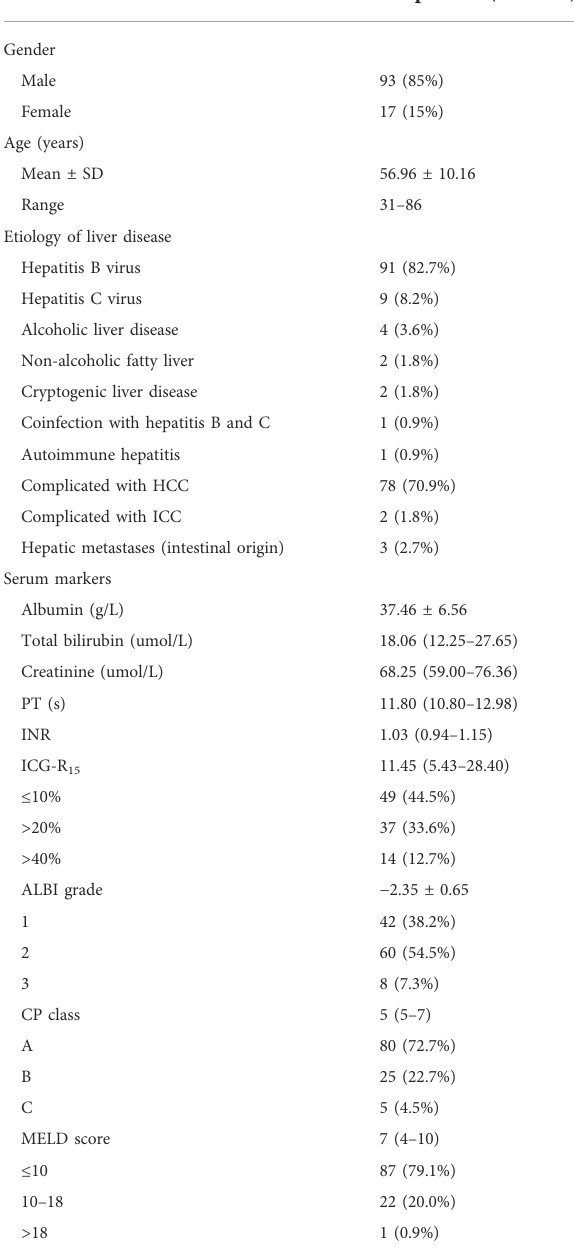
TABLE 3 Baseline characters of the study population. HCC, hepatocellular carcinoma; ICC, intrahepatic cholangiocarcinoma.